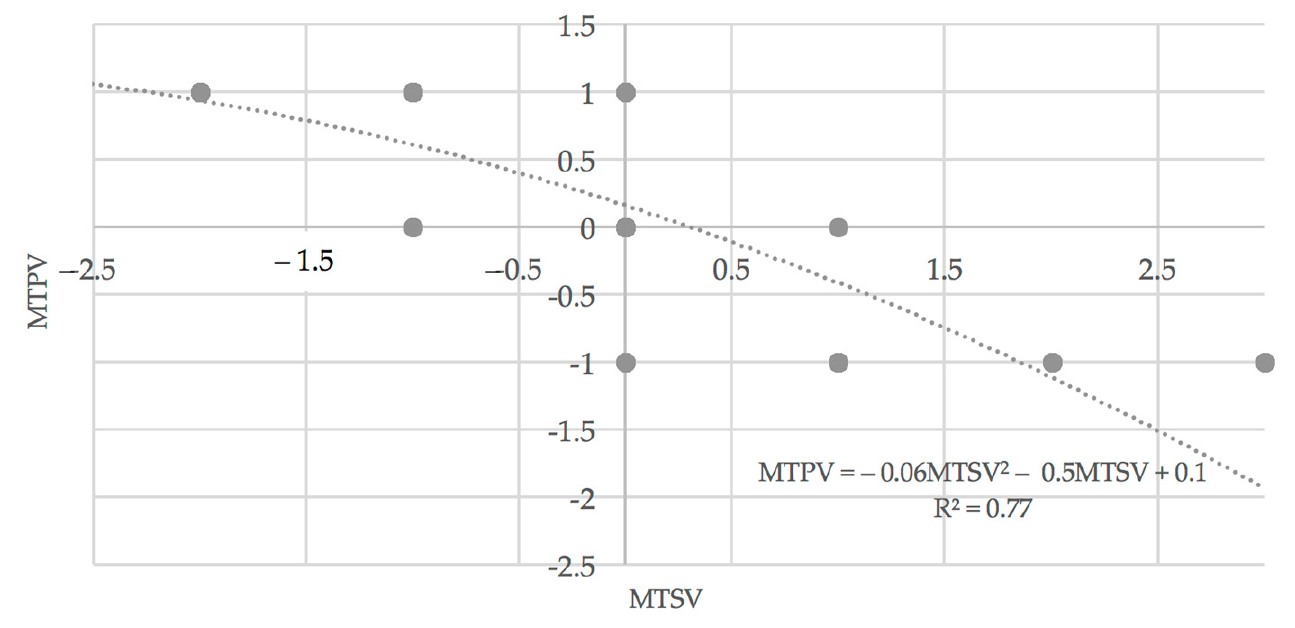
Figure 8. Mean thermal preferences compared with mean thermal sensation votes. For MTSV lower or equal to neutral, MTPV were usually between 0.5 and 1, indicating a desire for higher air temperature.